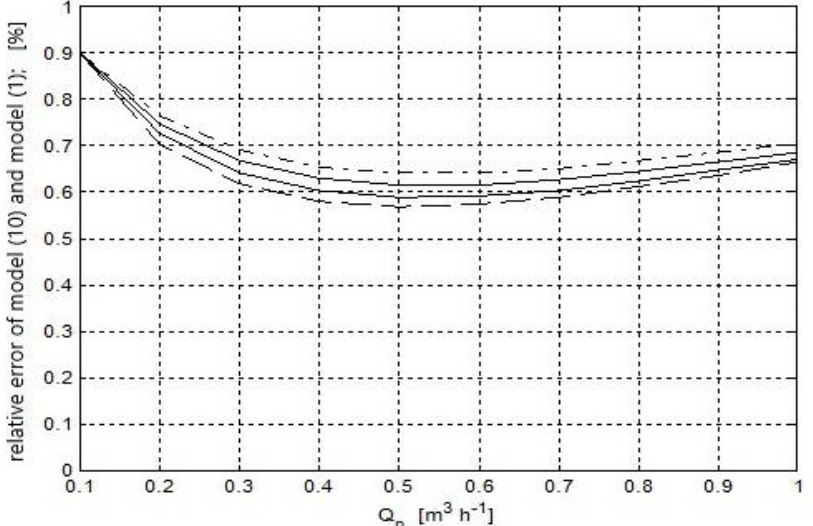
Figure 2. Relative errors of vacuum pressure drops calculated by model (1) and simplified model (10) for D = 0.016 m, H = 1.9 m , l dpm = 2.2 m, p o = 49.3 kPa and ξ = 0.5, λ = 0.03 for selected values of the milk stream in the range from 2 to 5 kg min −1 .